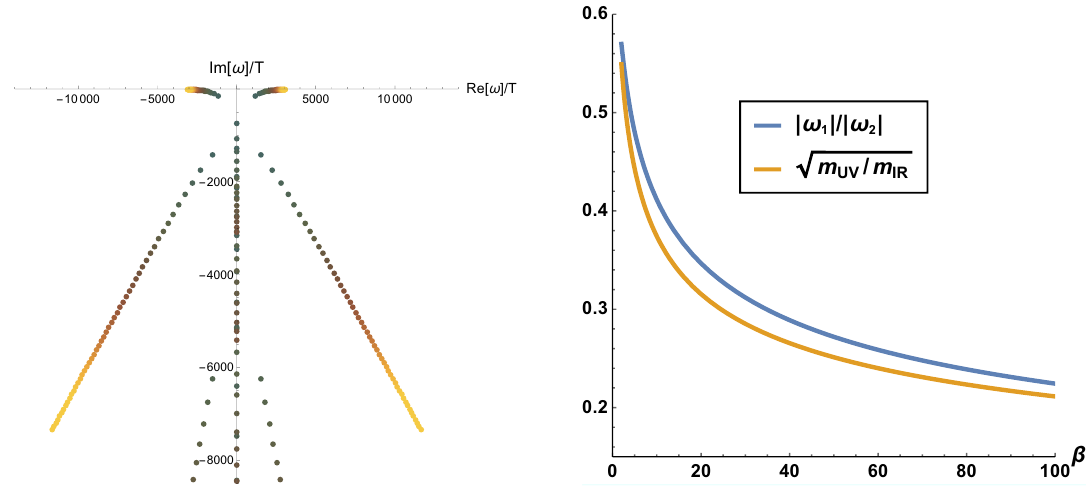
Figure 3 . Left: QNMs at k=0 for T=m = 0 : 001 and (cid:12) 2 [1 ; 100] (green-yellow). A qualitatively similar behaviour is found also for other values of T=m . Right: comparison between the ratio of the absolute values of the frequencies of the (cid:12)rst and the second lowest QNMs shown on the left p panel (blue) and the mass ratio m UV =m IR